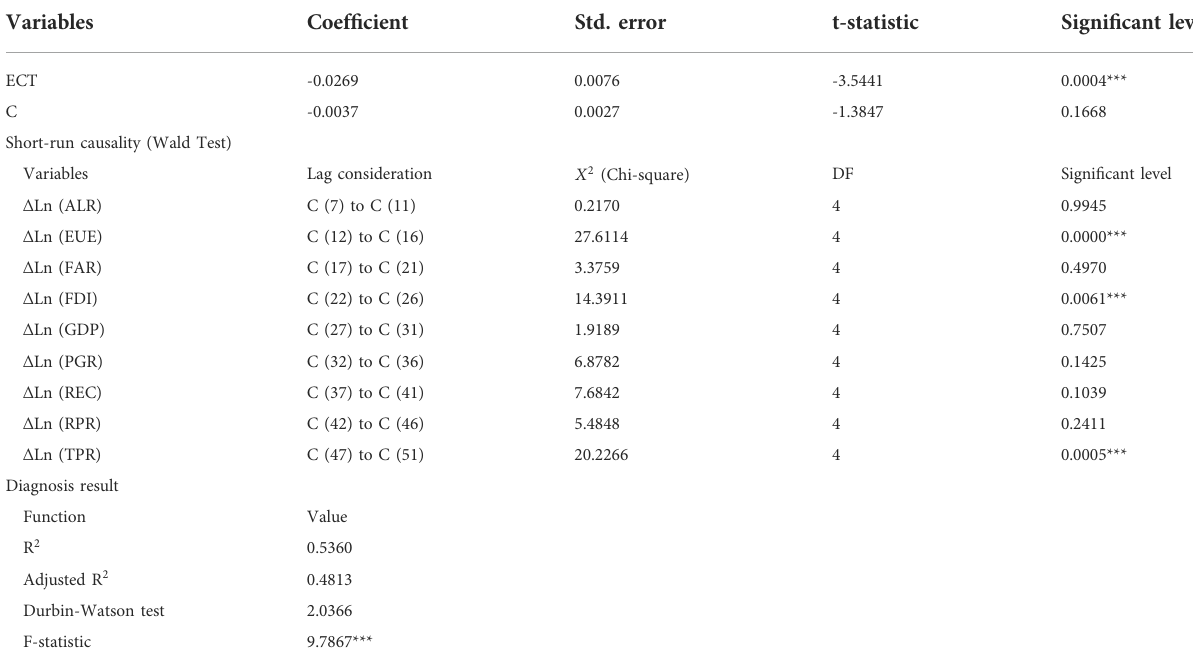
TABLE 7 VECM short-run and long-run